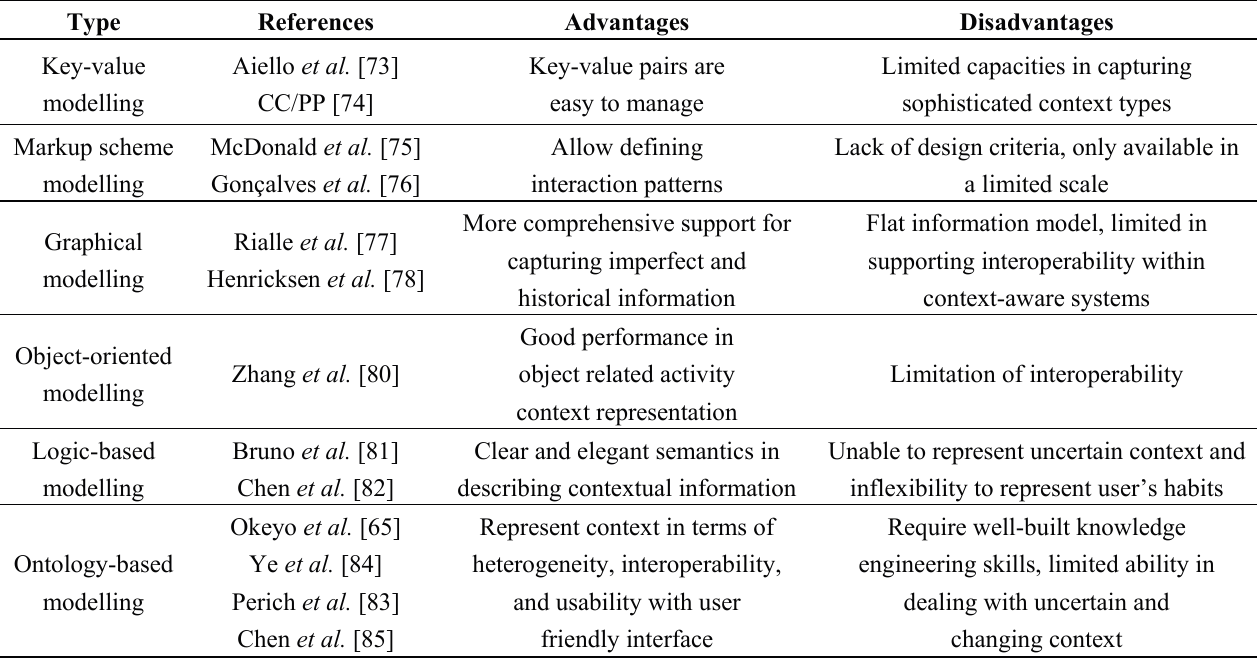
Table 3. Context representation: options for its